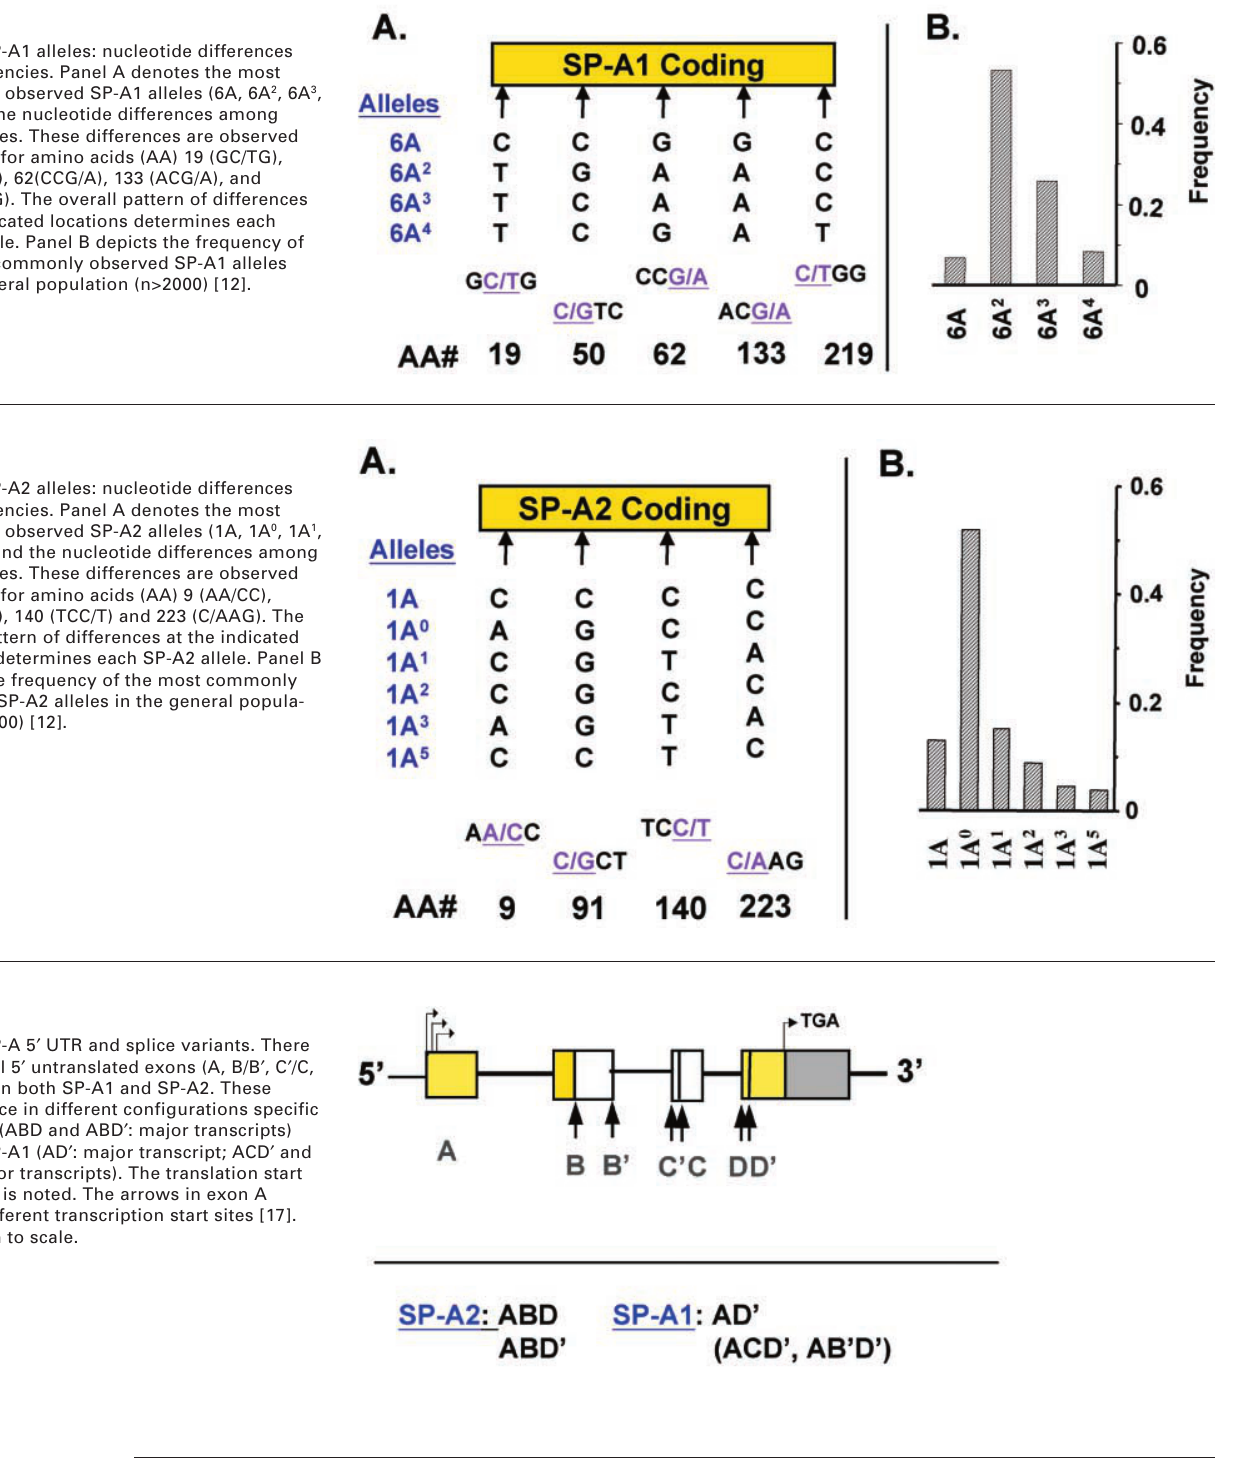
Human SP-A1 alleles: nucleotide differences and frequencies. Panel A denotes the most frequently observed SP-A1 alleles (6A, 6A 2 , 6A 3 , 6A 4 ) and the nucleotide differences among these alleles. These differences are observed in codons for amino acids (AA) 19 (GC/TG), 50 (C/GTC), 62(CCG/A), 133 (ACG/A), and 219(C/TGG). The overall pattern of differences at the indicated locations determines each SP-A1 allele. Panel B depicts the frequency of the most commonly observed SP-A1 alleles in the general population (n>2000) [12].